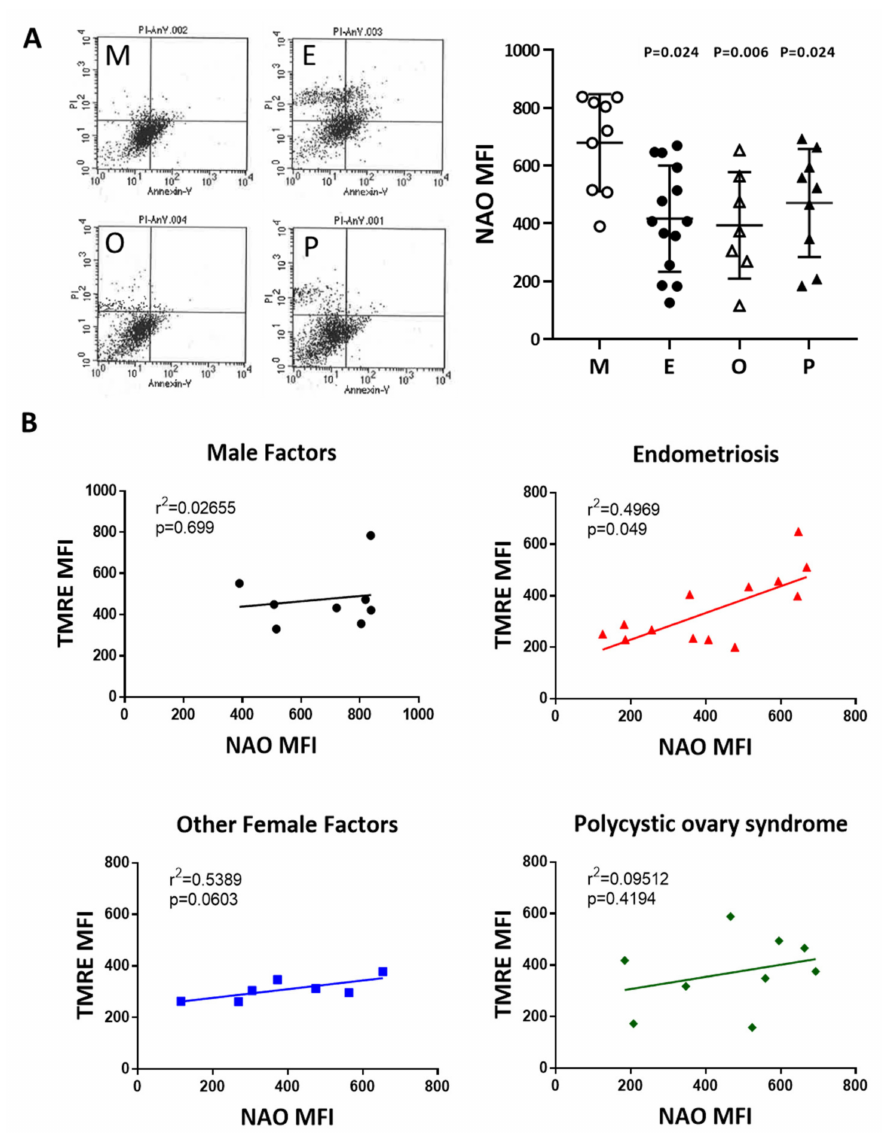
Figure 7. Comparison of mitochondrial mass in the various infertile groups. ( A ) The mitochondrial mass was measured by nonyl acridine orange (NAO) staining and flow cytometry. Reduced mitochondrial mass in cumulus cells was found in patients with endometriosis, other female factors, and PCOS. ( B ) The relationship between the mitochondrial potential and mitochondrial mass in the various groups was